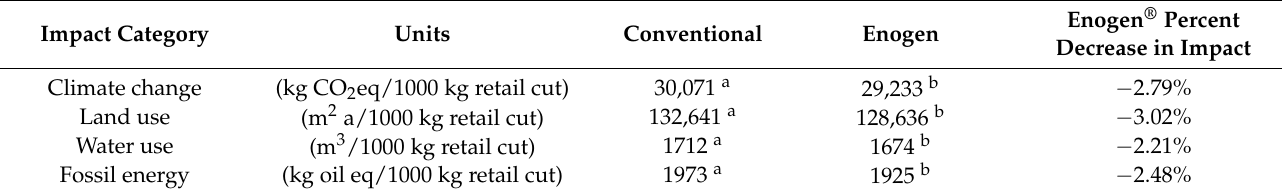
Table 5. Environmental impacts and improvements for cradle-to-harvest gate. Simulation with truncated BG and full FY conditions plus generic cow/calf and harvest facility models.